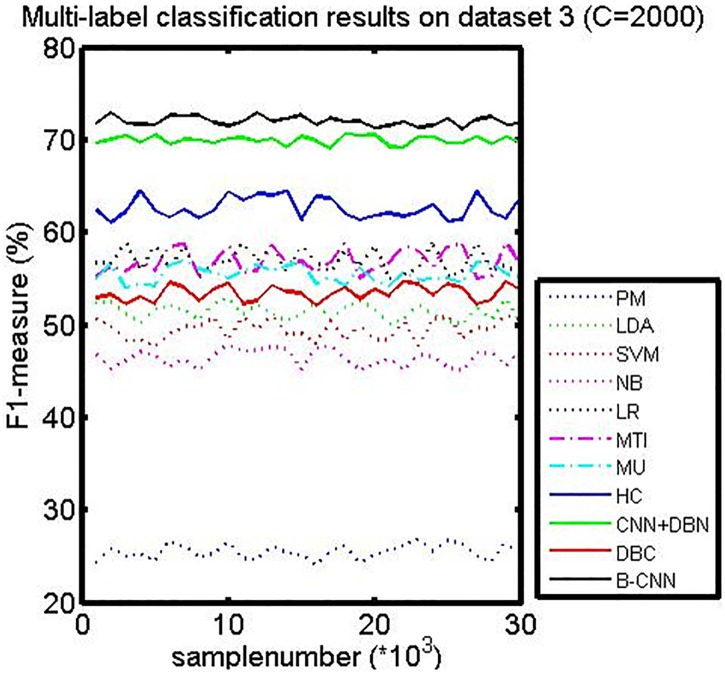
F1-measure curves on dataset 3.